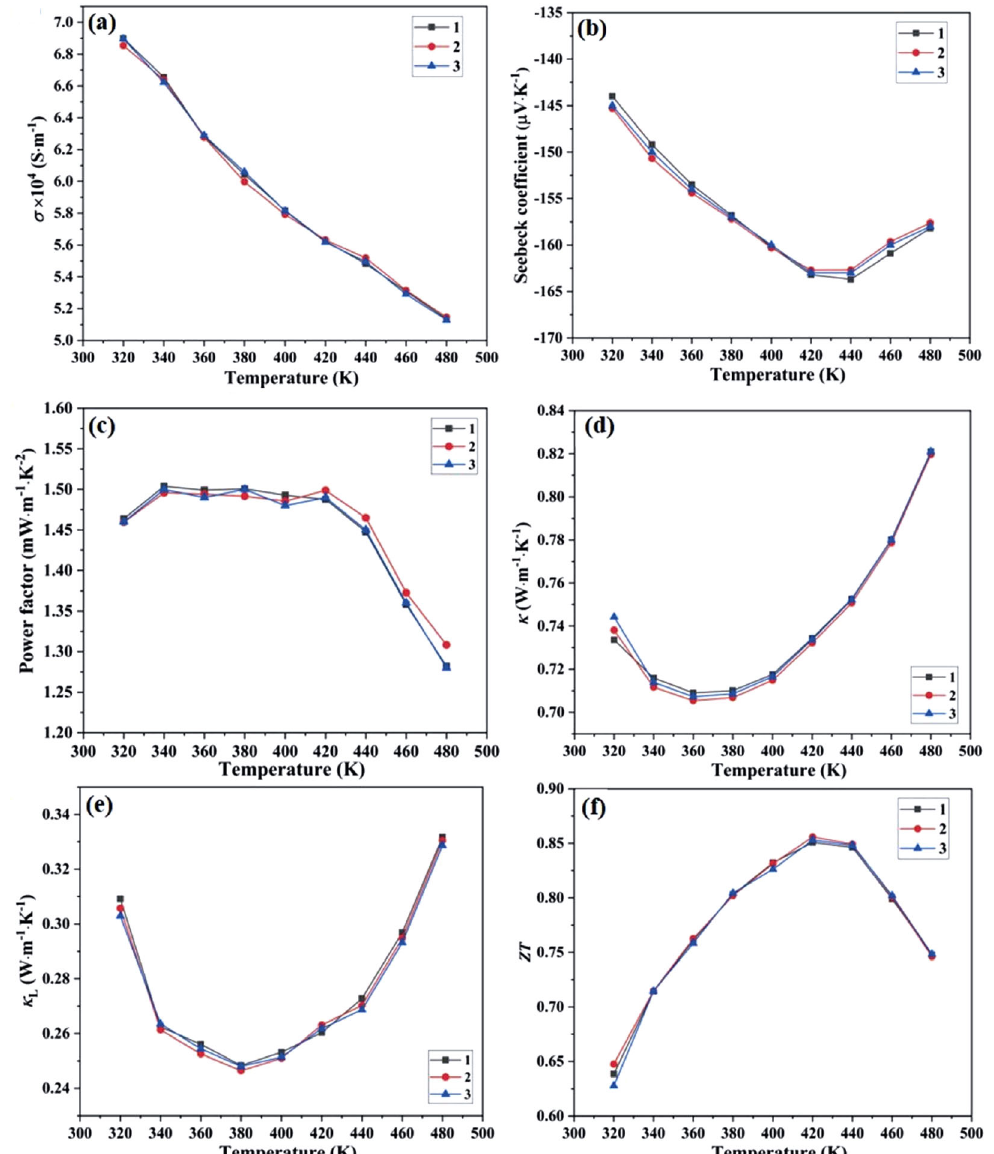
Fig. 5 Repeated tests of thermoelectric properties of Lu 0.1 Bi 1.9 Te 2.7 Se 0.3 sample: (a) electrical conductivity; (b) Seebeck coefficient; (c) power factor; (d) thermal conductivity; (e) lattice thermal conductivity; (f) ZT